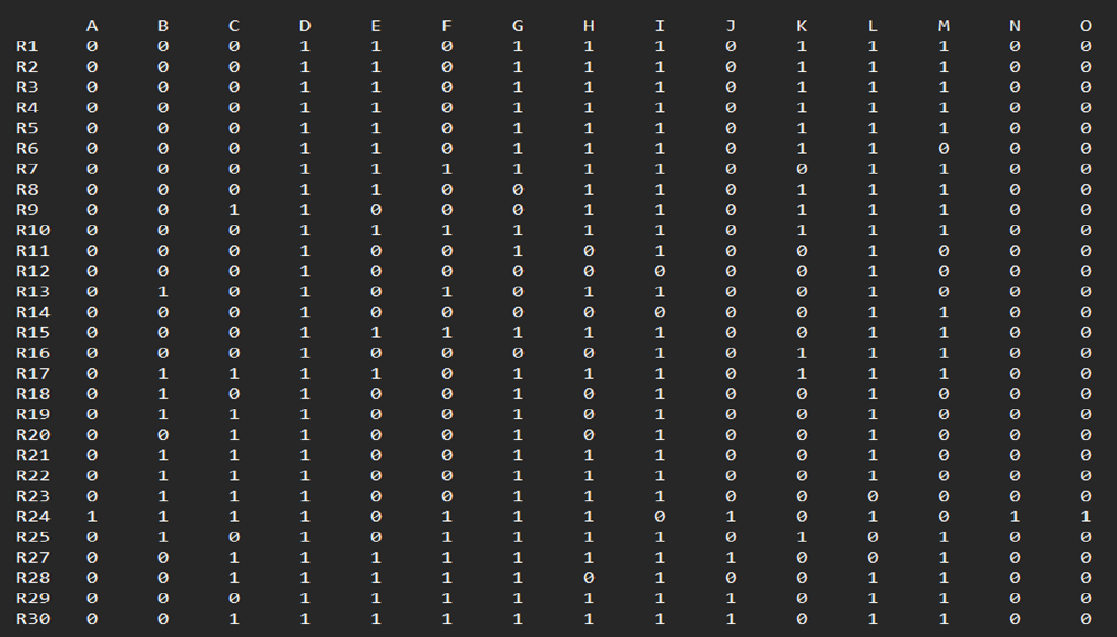
Figure S6. Binary data generated from visual analysis of banding patterns of the 29 isolates by RAPD (R1-R29). Columns A: 2000 bp, B: 1750 bp, C: 1500 bp, D: 1300 bp, E: 1200 bp, F: 1100 bp, G: 1000 bp, H: 900 bp, I: